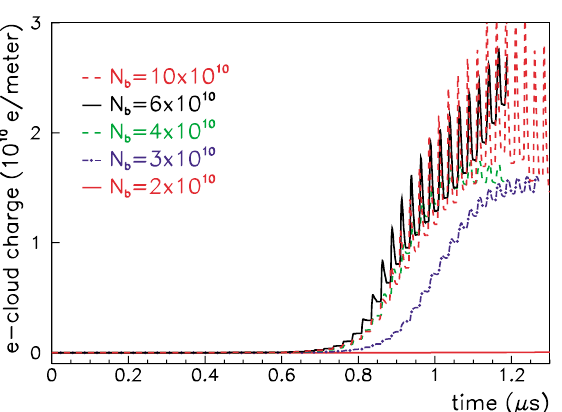
bunches).FIG. 5. (Color) Electron cloud buildup in a PS combined func- tion magnet during the first 1 : 3 (cid:16) s of the bunch train for different bunch intensities. The electron cloud reaches satura- tion after the passage of about 50